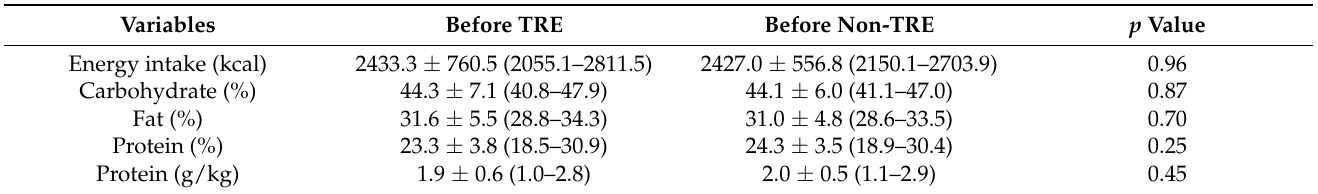
Table 1. Estimated daily dietary intake obtained on four days immediately before time-restricted eating (TRE) and habitual diet